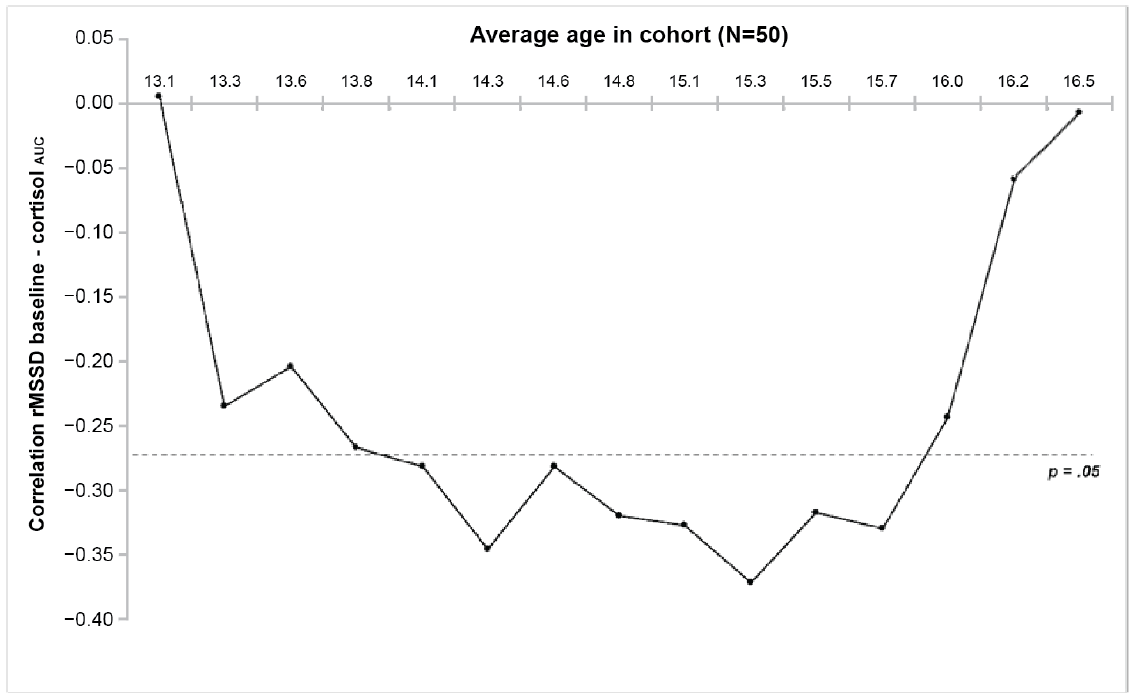
Figure 5. The correlation between baseline rMSSD and cortisol response to the public speaking task changes with age: significant correlations were found between 14 and 16 years of age.